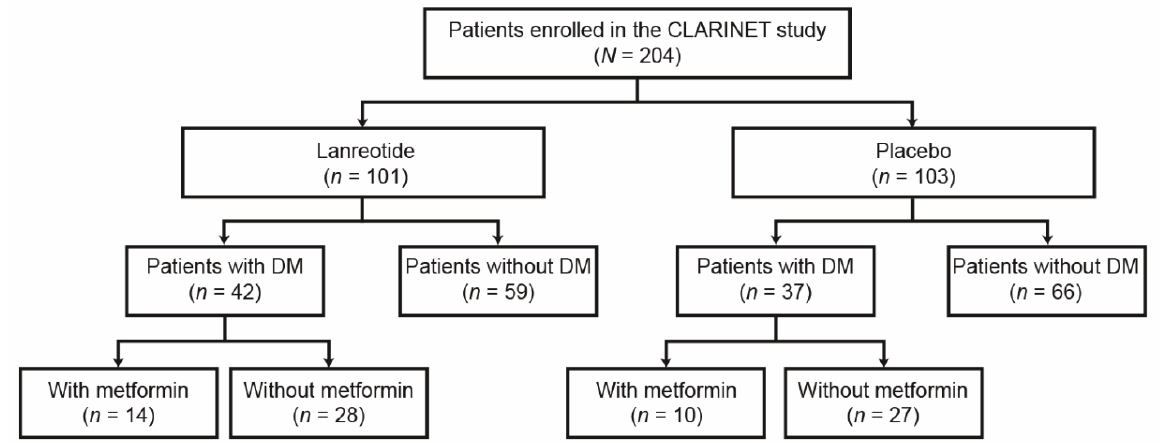
Figure 1. Patient flow diagram. Further details of patient disposition from the CLARINET study are reported in Caplin et al., 2014 [19]. DM, diabetes mellitus.